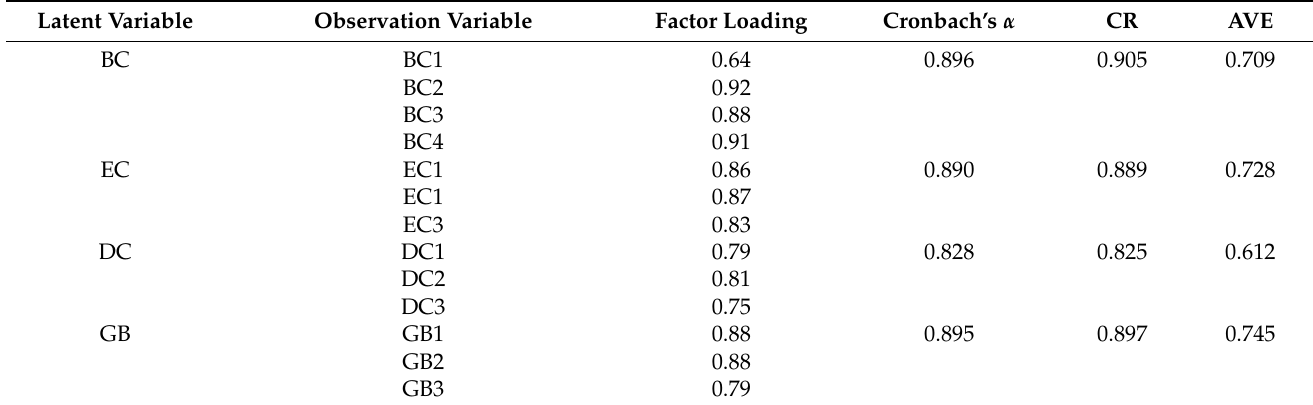
Table 6. Results of reliability test.